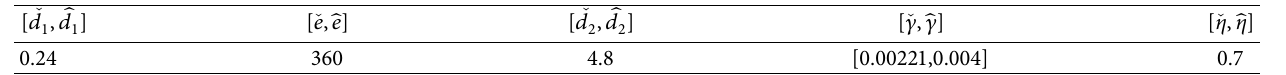
Figure 6: Spatial mean density of the prey with respect to interval variable q . Table 5: Parameters set in subsection